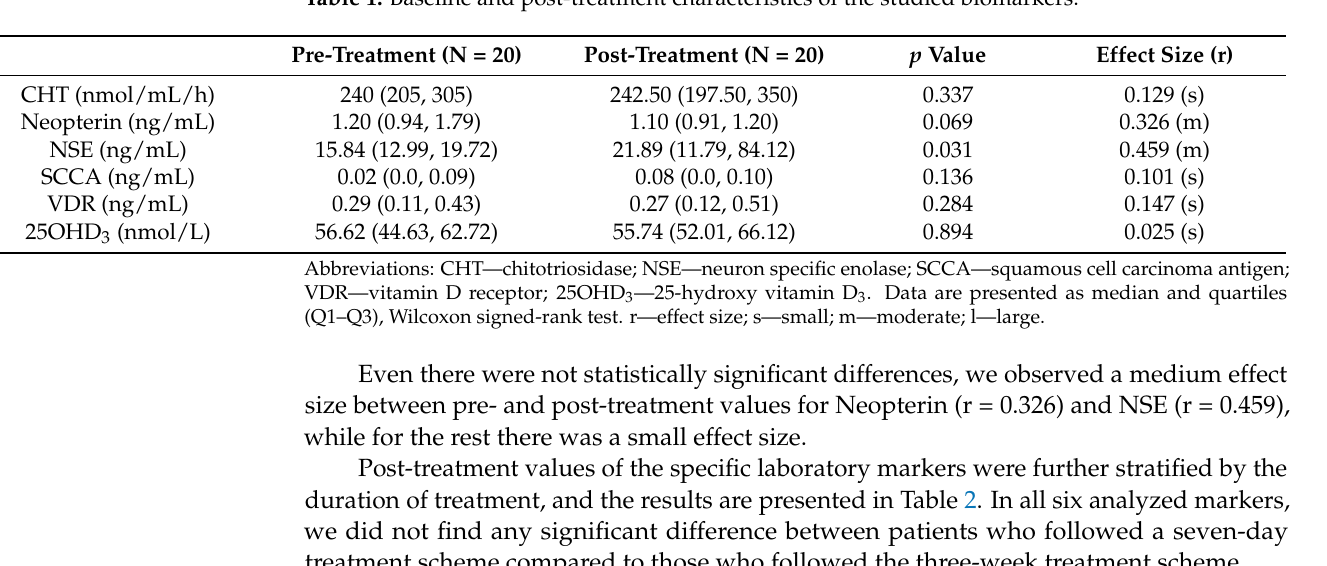
Table 1. Baseline and post-treatment characteristics of the studied biomarkers.